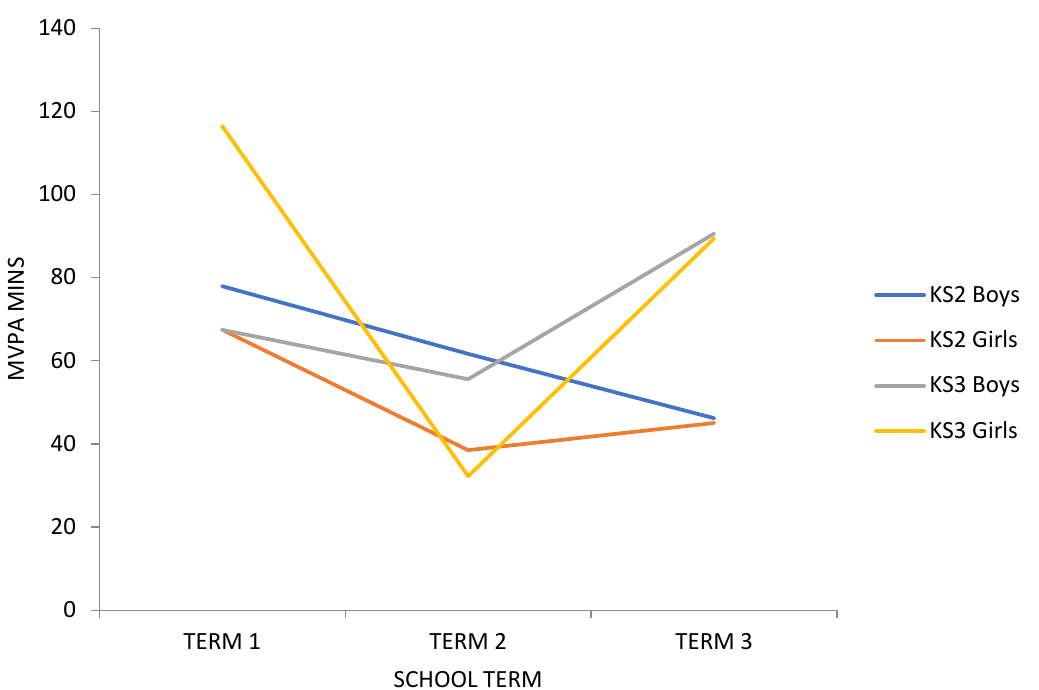
Figure 1. Mean daily moderate–vigorous physical activity (MVPA) time (mins) according to gender within key stage each school term.